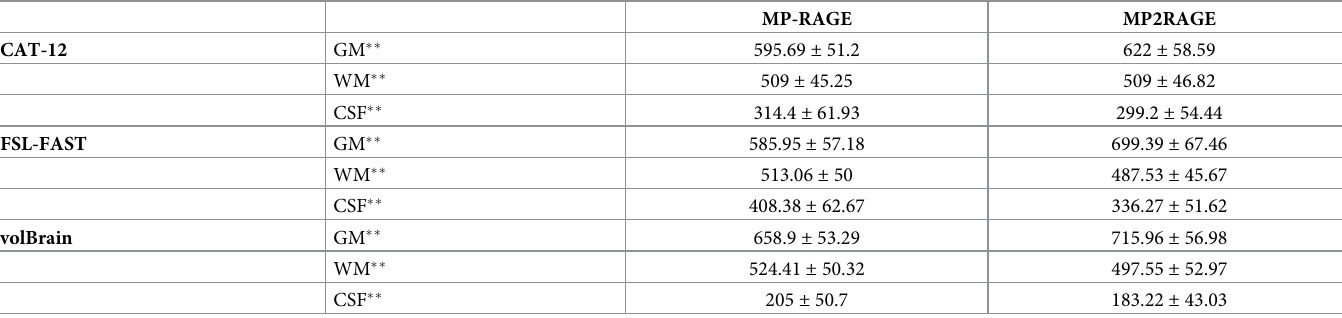
Table 2. Whole-brain GM, WM, and CSF volumes obtained from the segmentation of MP-RAGE and MP2RAGE images using the different automatic segmenta- tion